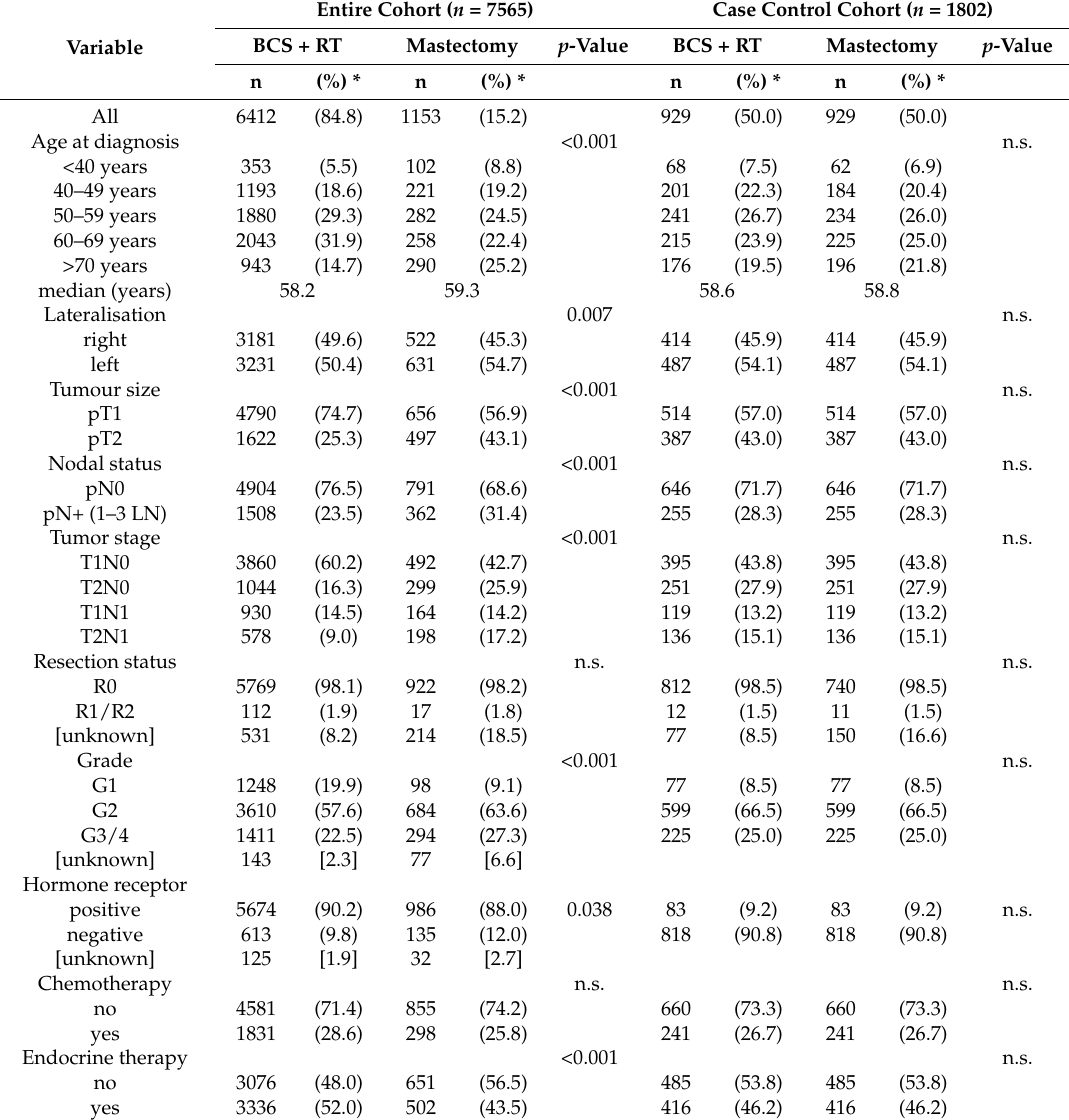
Table 1. Patient and tumor characteristics for the entire cohort and the case control